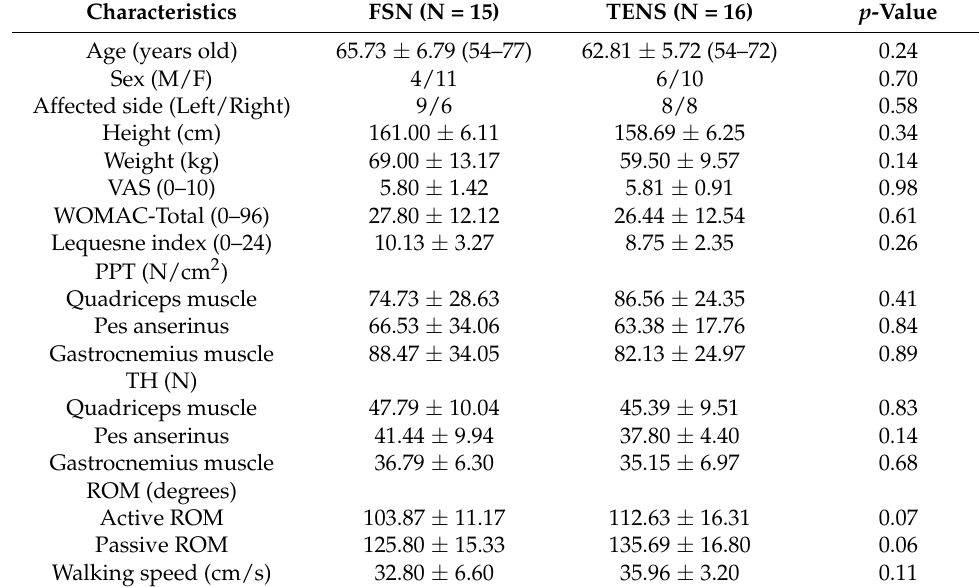
Table 1. Baseline characteristics and clinical evaluation indicators of participants.